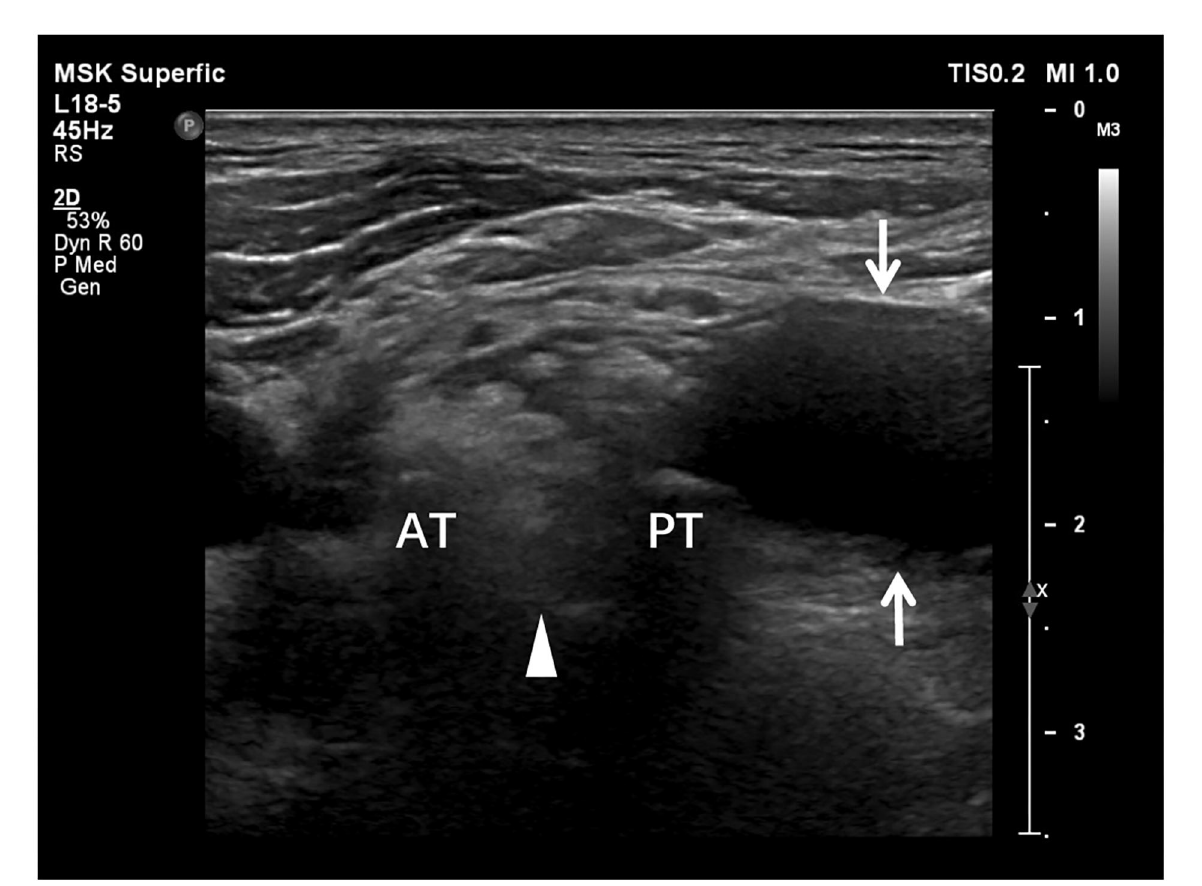
FIGURE3 Transverse sonogram shows the accumulated cerebrospinal fluid, i.e., pseudomeningocele, adjacent to the intervertebral foramen. The cerebrospinal fluid (arrows) appears anechoic. The absence of brachial plexus root (arrowhead) between anterior (AT) and posterior tubercles (PT) represents preganglionic root